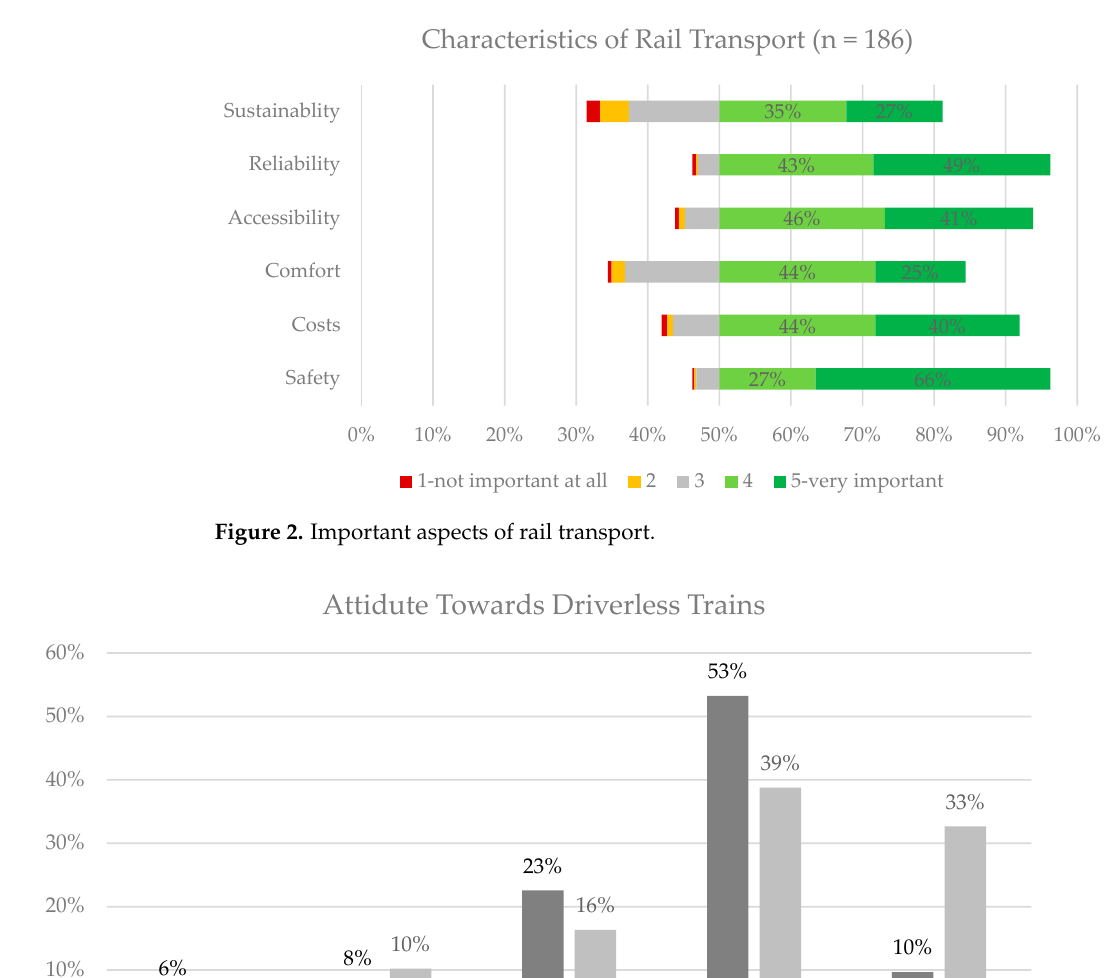
Figure 2. Important aspects of rail transport.